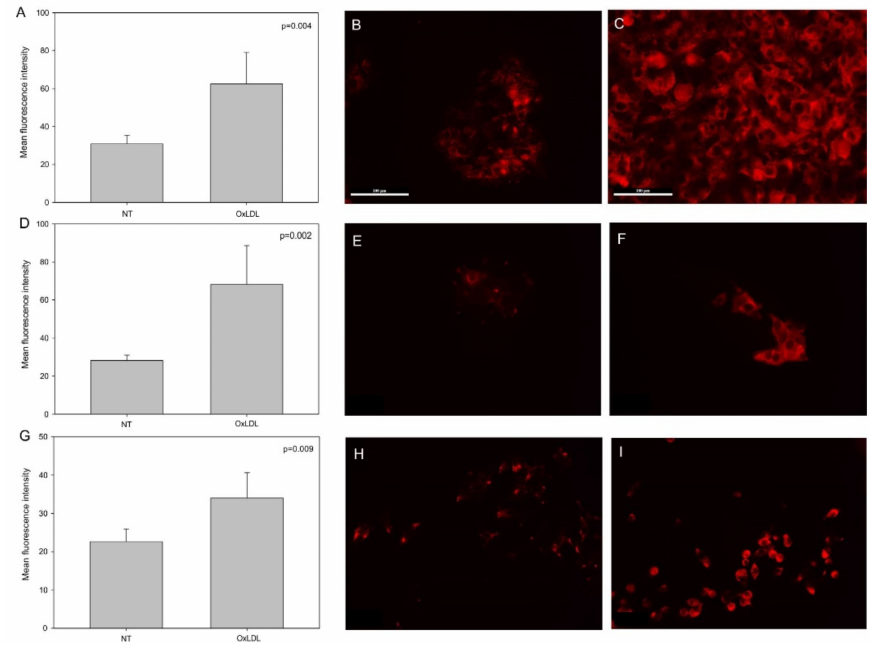
Figure 3. Lox-1 expression in HNC cell lines. ( A , D , G ) Mean fluorescence intensity of Lox-1 increased significantly under oxLDL exposure in FaDu cells ( t -test, p = 0.004, n = 6), Detroit 562 cells ( t -test, p = 0.002, n = 6) and UPCI-SCC-131 cells ( t -test, p = 0.009, n = 6) (mean ± SD, o: datapoint). ( B , E , H ) Representative immunofluorescence of Lox-1 in FaDu, Detroit 562 and UPCI-SCC-131 cells, respectively, without oxLDL (NT) or ( C , F , I ) with 30 µ g of